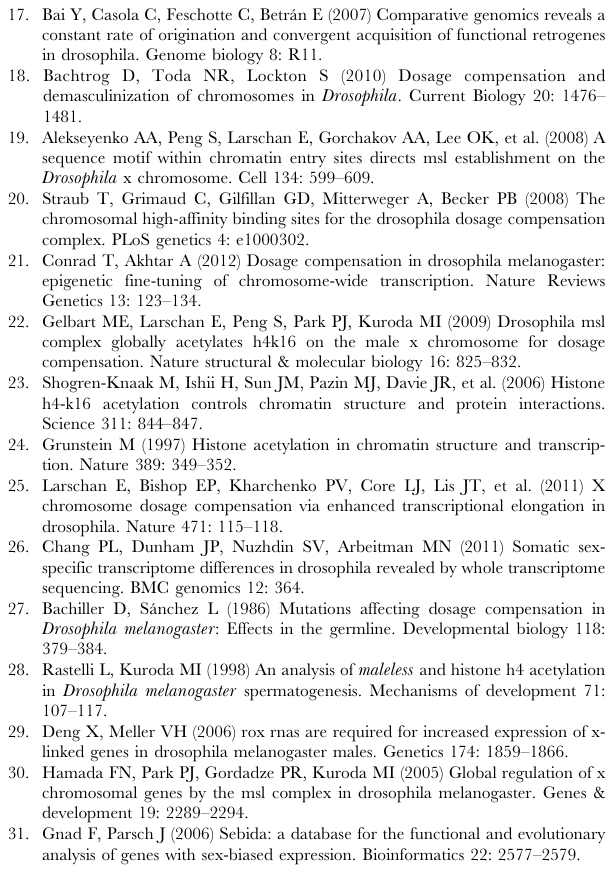
Figure S5 Relationship between sex-bias magnitudes and distance from nearest CES using whole fly expres- sion data from Ayroles et al., 2009 . Using whole body expression from Ayroles et al., 2009 we found a significant positive correlation between sex-bias magnitude and distance from the nearest CES when considering all X -linked MBGs (purple line, r ~ 0 : 31, p v 0 : 001 ). After partitioning X -linked MBGs into testis- biased and non-testis-biased we were unable to find any significant correlation for non-testis-biased MBGs (dashed red line, r ~ 0 : 12, p § 0 : 05 ) or testis-biased MBGs (dashed blue line, Figure S6 Relationship between sex-bias magnitudes and distance from nearest CES using head-specific expression data from Goldman et al., 2007 . Using head- specific expression from Goldman et al., 2007 we could not find a significant positive correlation between sex-bias magnitude and distance from the nearest CES when considering all X -linked MBGs (purple line, r ~{ 0 : 001, p § 0 : 05 ). It is unnecessary to filter out testis-biased MBGS since somatic comparisons between males and females do not allow for the excessively high male-bias magnitudes from the germline to drive any artifactual signals. Figure S7 Relationship between sex-bias magnitudes and distance from nearest CES using whole fly expres- sion data from Stolc et al., 2004 . Using whole body expression from Stolc et al., 2004 we found a significant positive correlation between sex-bias magnitude and distance from the